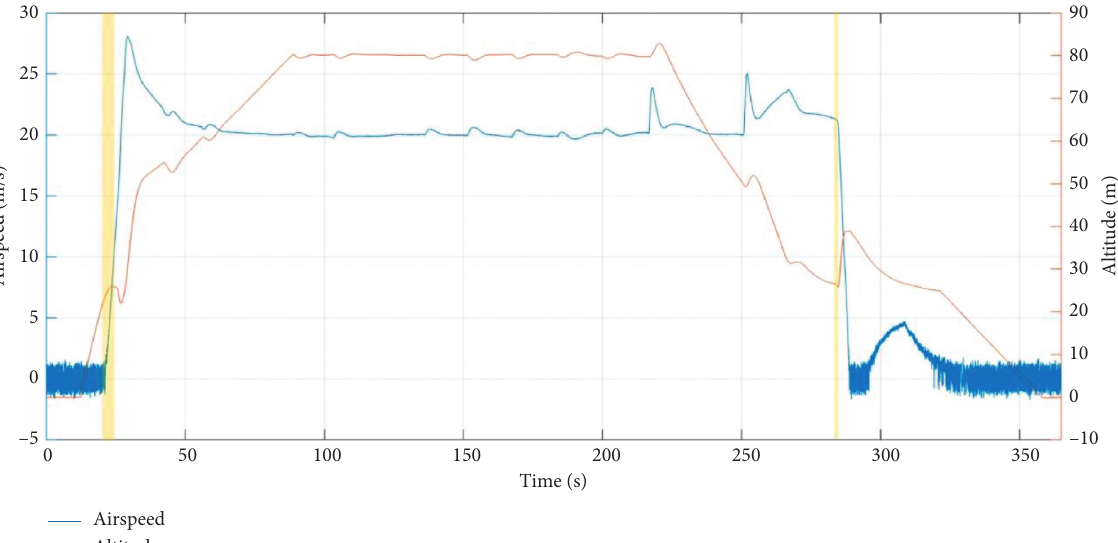
Figure 15: Airspeed and altitude of the aircraft in HIL simulation.